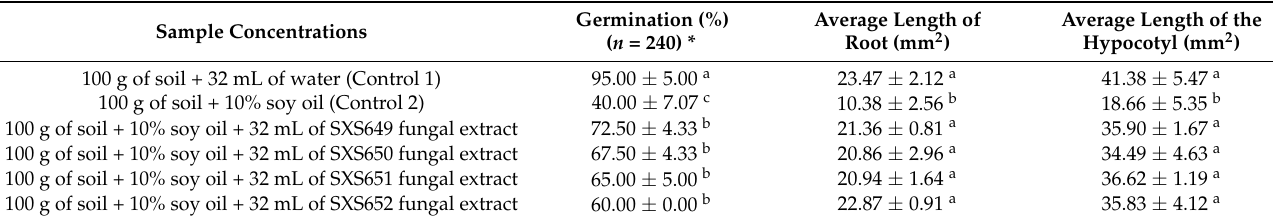
Table 4. Viability of Lactuca sativa seeds in soil contaminated with 10% soybean oil and treated with extracts (32 mL) of the endophytic fungi Colletotrichum sp. SXS649, Pestalotiopsis sp. SXS650, Botryosphaeriales SXS651, and Diaporthe sp. SXS652 isolates from P. rigida Kunth.